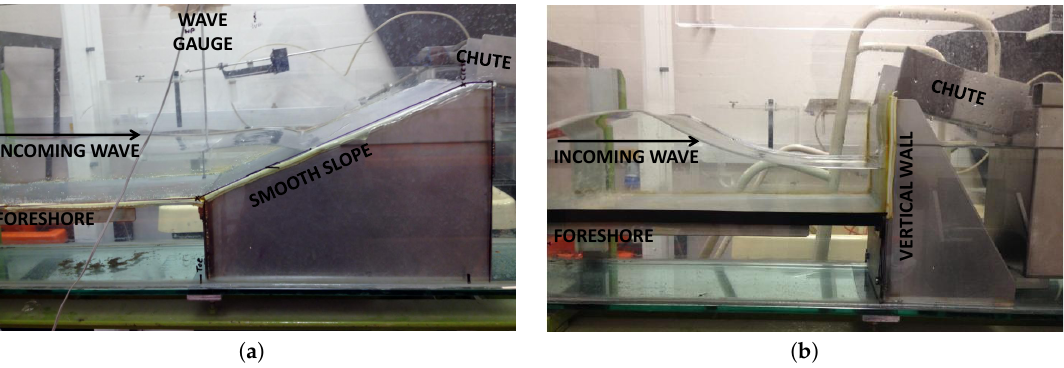
Figure 2. Photographs of the University of Nottingham experimental set-up. ( a ) smooth impermeable slope; ( b ) vertical